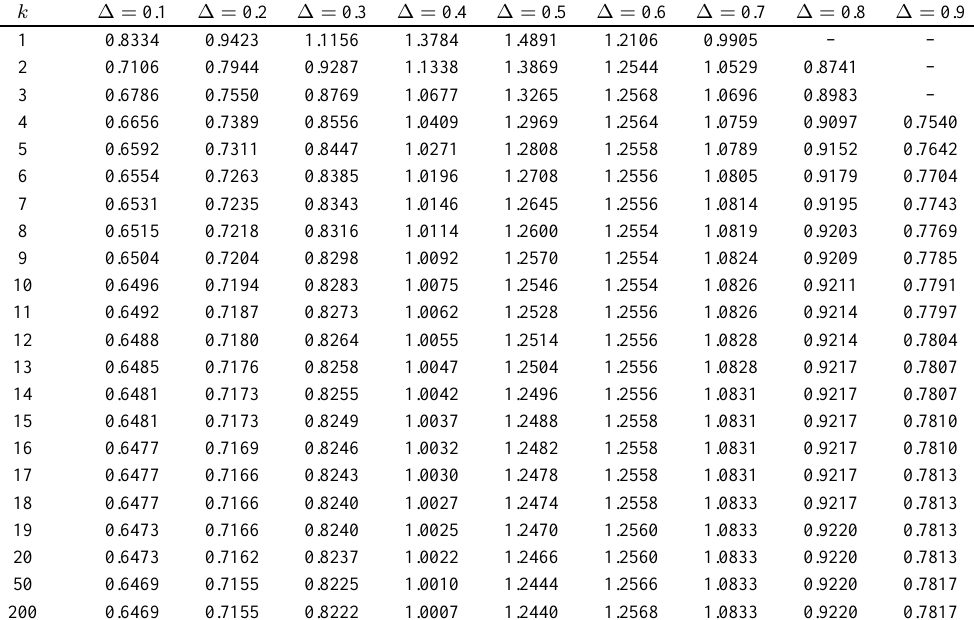
Table 11 Frequency parameter λ (Case 2, c = 2 , d = 14 ,